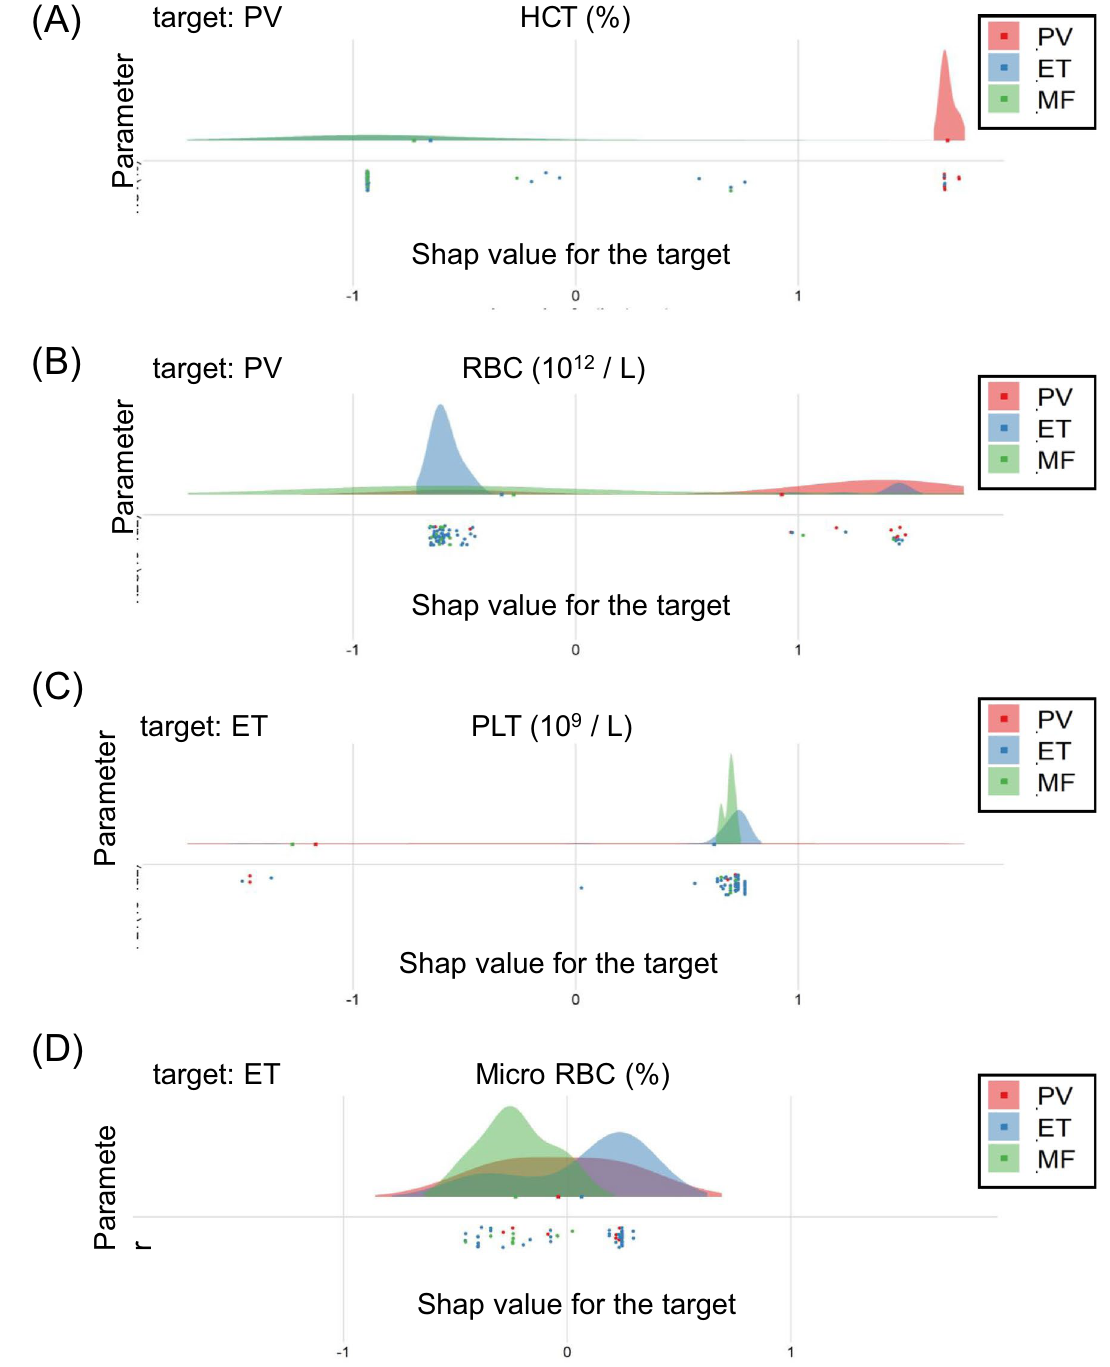
Figure 3. Performance of the DLS-based diagnostic system. ( E – H ) The calculated SHAP values are used to outline the useful parameters in the differentiation of Ph-negative MPNs by plotting the SHAP values of positive and negative likelihood to differentiate each disease. SHAP values close to 1 denote high likelihood, whereas those close to -1 denote less